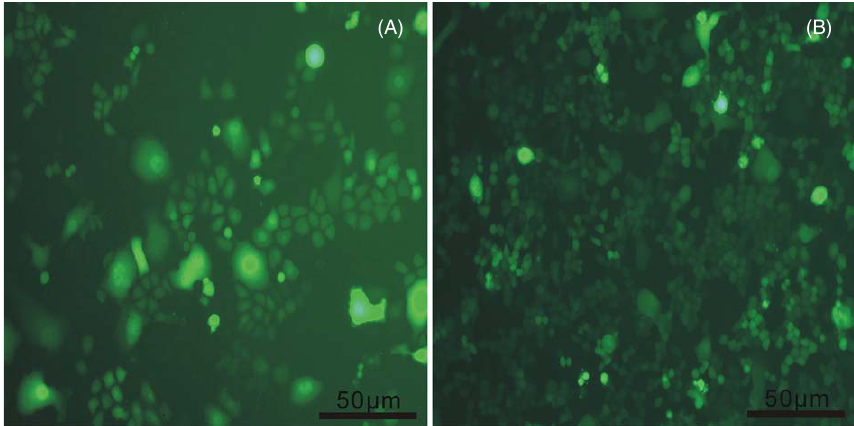
Fig. 1. SGC-7901 transduced with lentiviral vectors. (A) Selected cells (parental SGC-7901) were transduced with let-7a lentiviral vectors at a multiplicity of infection of 5 and selected for stable integrants using EGFP reporter gene. Original magnification: × 200. (B) Selected cells (parental SGC-7901) were transduced with empty lentiviral vectors at a multiplicity of infection of 5 and selected for stable integrants using EGFP reporter gene. Calibration bar is 50 (cid:1) m for both panels.